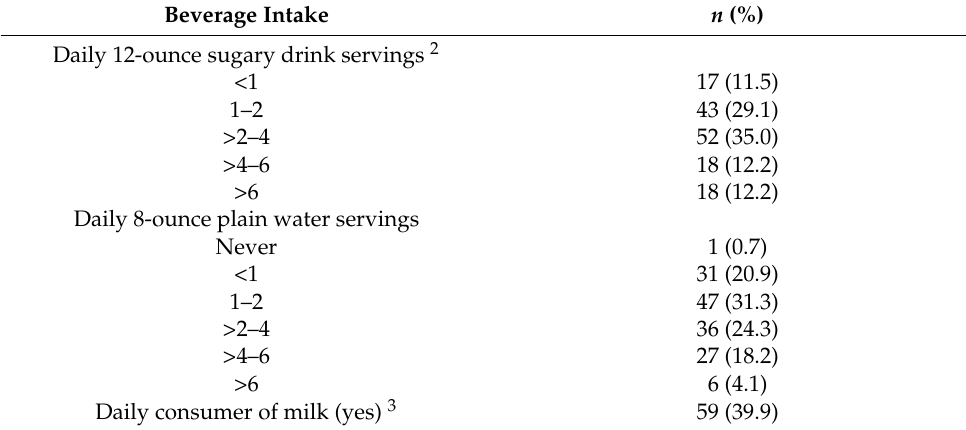
Table 2. Participants’ habitual beverage intake, as reported at baseline, n = 148 1